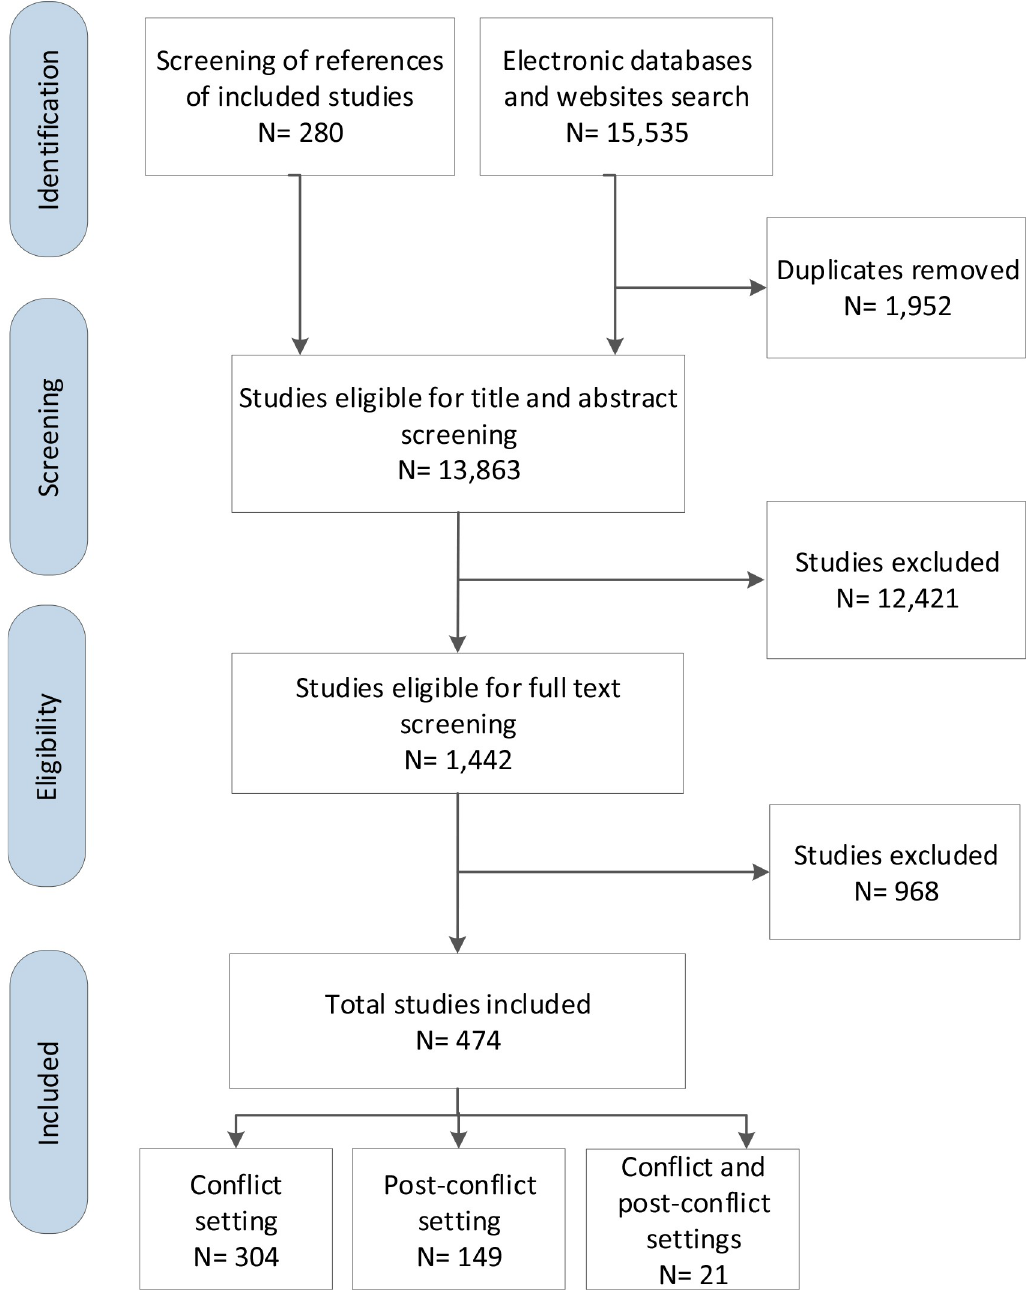
Fig 1. Preferred Reporting Items for Systematic reviews and Meta-Analyses (PRISMA) study flow diagram for selection. health workers (41%), followed by health or medical practice (34%) and education (21%). For post-conflict settings, besides the themes adopted from Roome et al. (2014) [5], an emerging theme was the mental health of HCWs. The majority of the included papers on post-conflict settings addressed the workforce performance theme (77%) followed by workforce supply (58%).